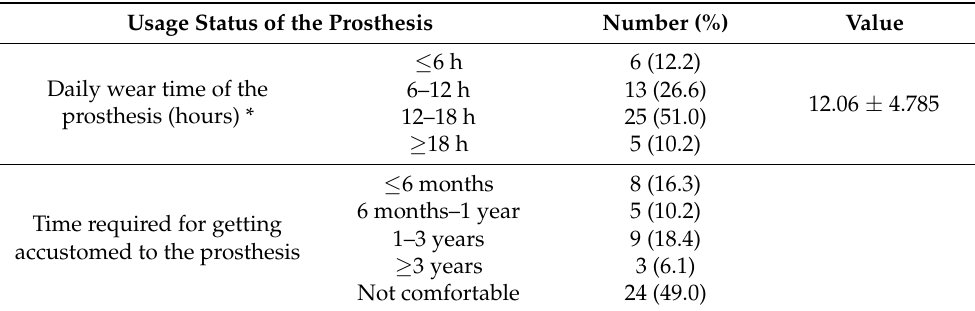
Table 5. Usage status of the prosthetic upper limb ( n =